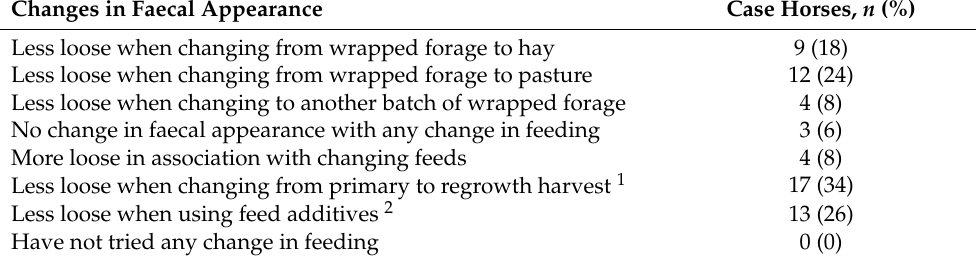
Table 4. Changes in the appearance of free faecal liquid in the horses in the study ( n = 50) with diet changes, as reported by respondents. “Less loose” refers to reduced amount of liquid phase in faeces compared to before the feed change. Not all respondents had tried all listed changes, and some had tried more than one change.